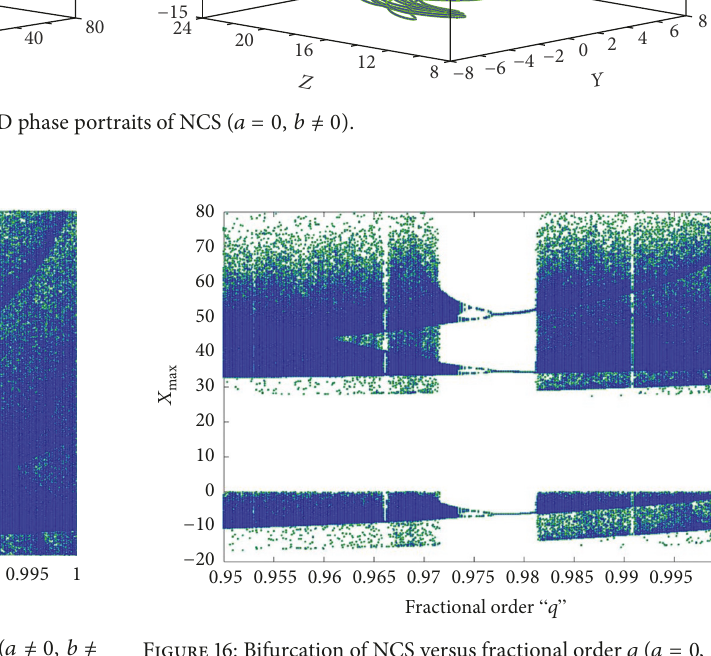
Figure 15: Bifurcation of NCS versus fractional order 𝑞 ( 𝑎 ̸= 0, 𝑏 ̸= 0 ).